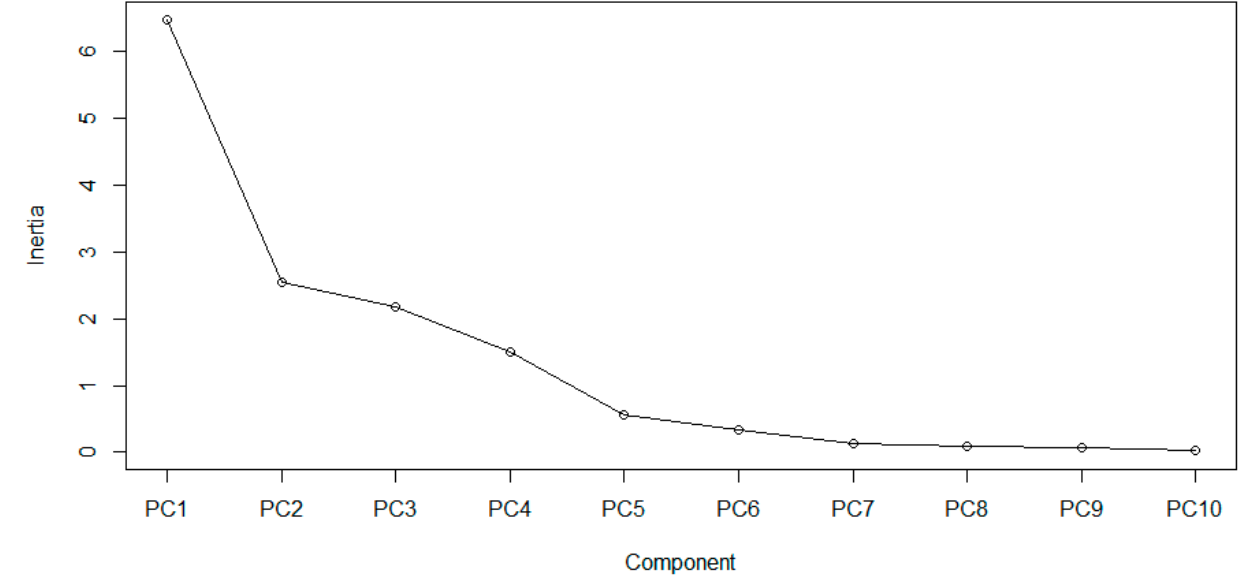
Figure A11. Community weighted mean Ellenberg’s indicator Nitrogen value depending on the distance from the drainage ditch and the dose of wood-ash fertiliser. Different letters (a, b, c) indicate significant differences between groups, p < 0.05 according to the Tukey HSD test.